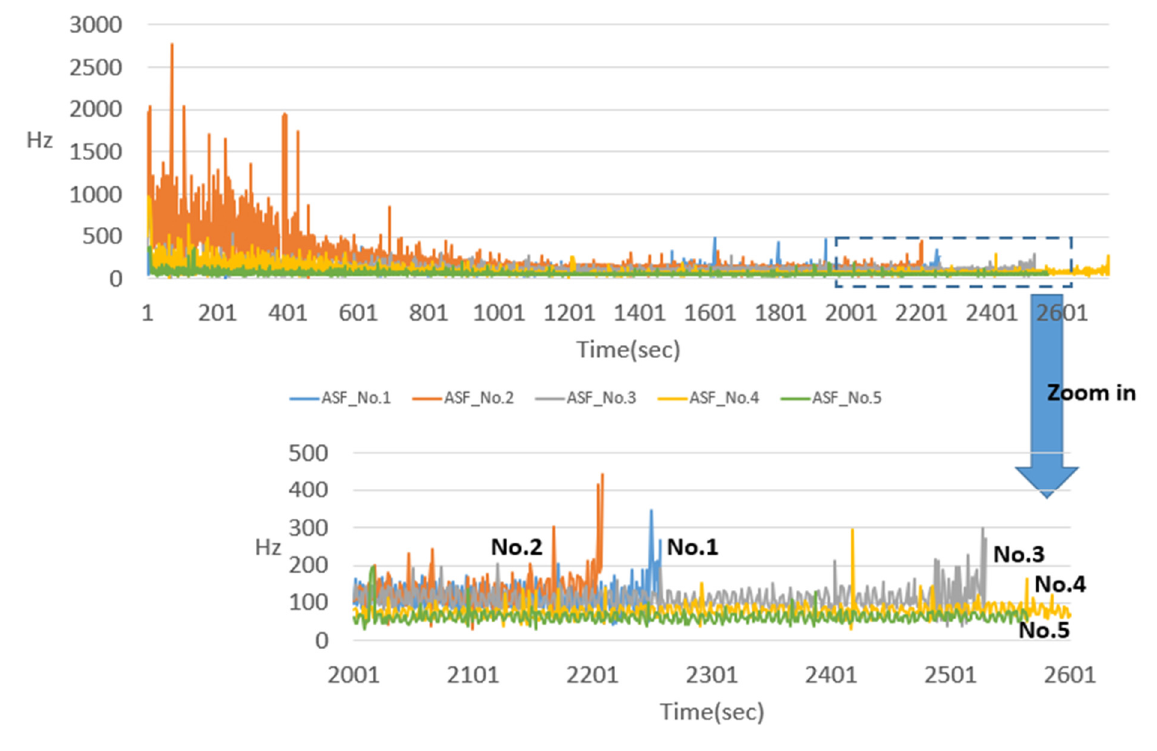
Figure 15. Average spark frequency.